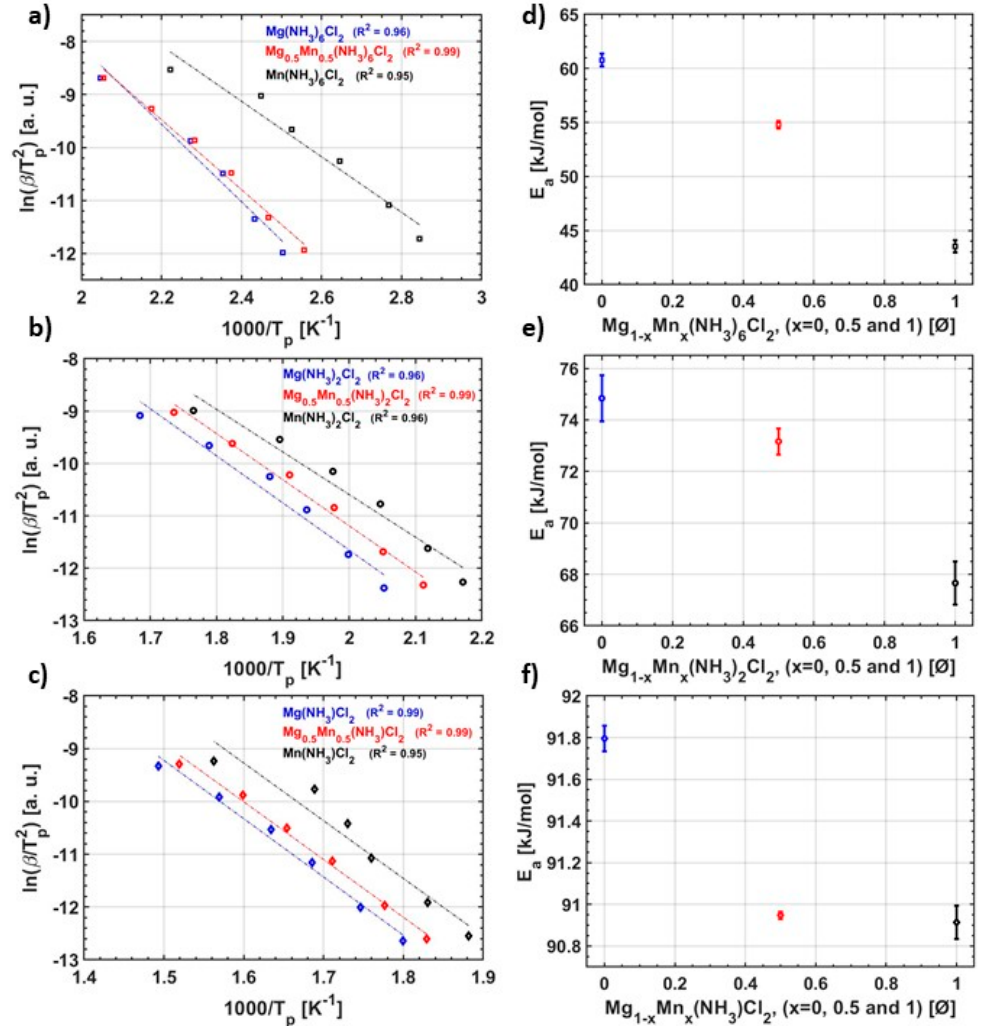
Figure 4. Kissinger analysis of the three desorption events occurring in Mg(NH 3 ) 6 Cl 2 (blue), Mg 0.5 Mn 0.5 (NH 3 ) 6 Cl 2 (red) and Mn(NH 3 ) 6 Cl 2 (black). The left column ( a – c ) shows the Kissinger plot which corresponds to the release of (a) 4 NH 3 (b) 1 NH 3 and (c) 1 NH 3 . β is the heating rate and T p is the corresponding peak temperature. The right column ( d – f ) shows the corresponding activation energies (E a ) for the three desorption events as determined by the Kissinger method. The R-values for each linear fit are included in the graphs.